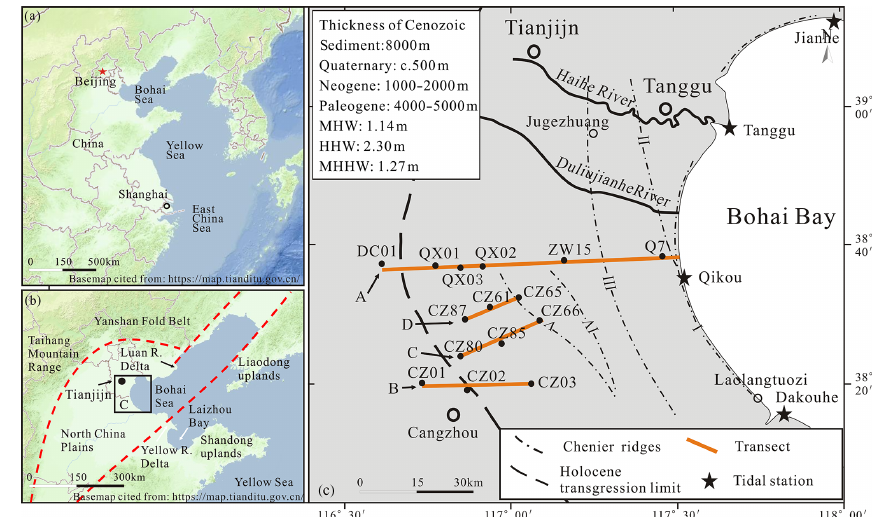
Figure 1. The study area: (a) location of Bohai Bay and Yellow Sea; (b) location of the study area and major river deltas; red dashed lines indicate the topographic boundaries of coastal lowland; (c) locations of boreholes, transects A, B, C, D, chenier ridges (Su et al., 2011; Wang et al., 2011) and Holocene transgression limit (Xue, 1993). The base maps of Fig. 1a and b are cited from “map world” (https: //www.tianditu.gov.cn/, last access: June 2020, National Platform for Common GeoSpatial Information Services,